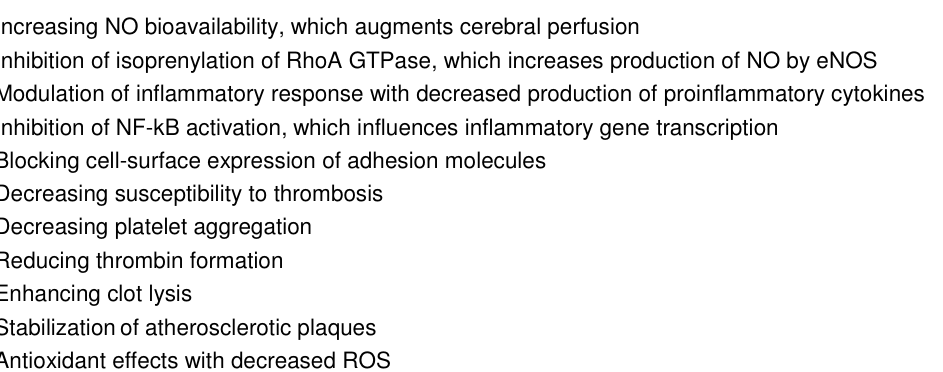
Pleiotropic Effects of Statins with Neuroprotective Benefits Increasing NO bioavailability, which augments cerebral